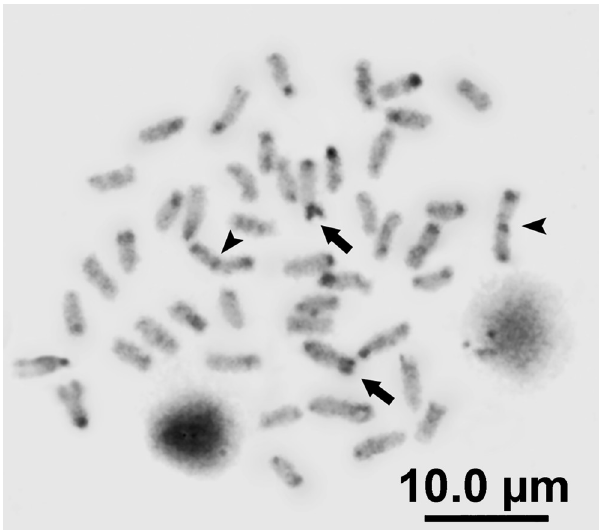
Figure 3. Somatic C-banded metaphases of the Pacific white mullets. Arrowheads indicate chromosome pair number one. Arrows indicate terminal heterochromatic blocks on chromosome pair 15. Scale bar: 10